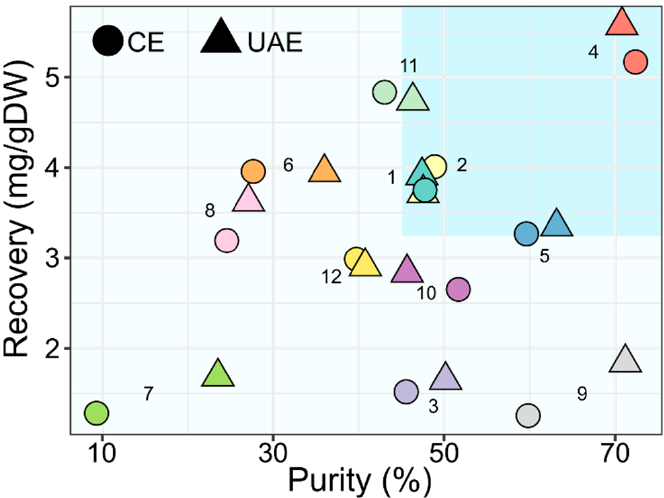
Figure 2. Purity–recovery graph for JB extraction. Purity is expressed as percentage (%), recovery is expressed as milligrams for gram of dry weight (mg/g DW). In the top-right section, extractions above the average within the solvents employed are shown.